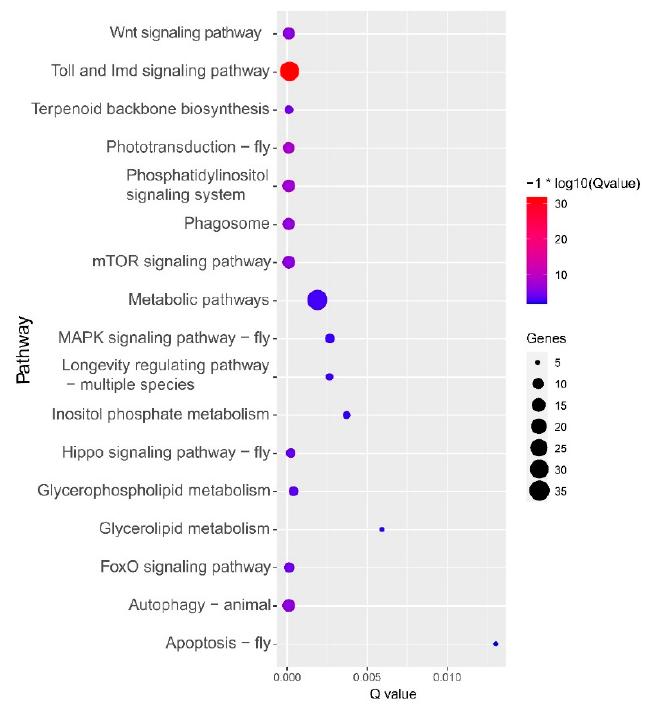
Figure 4. Kyoto Encyclopedia of Genes and Genomes (KEGG) enrichment of common upregulated genes of high-altitude B. pyrosoma compared to low-altitude B. pyrosoma from three sampling sites using the KOBAS 3.0 server (http://kobas.cbi.pku.edu.cn/) against the Apis mellifera database. Imd: immune deficiency, mTOR: mechanistic target of rapamycin, MAPK: mitogen-Activated Protein Kinase.